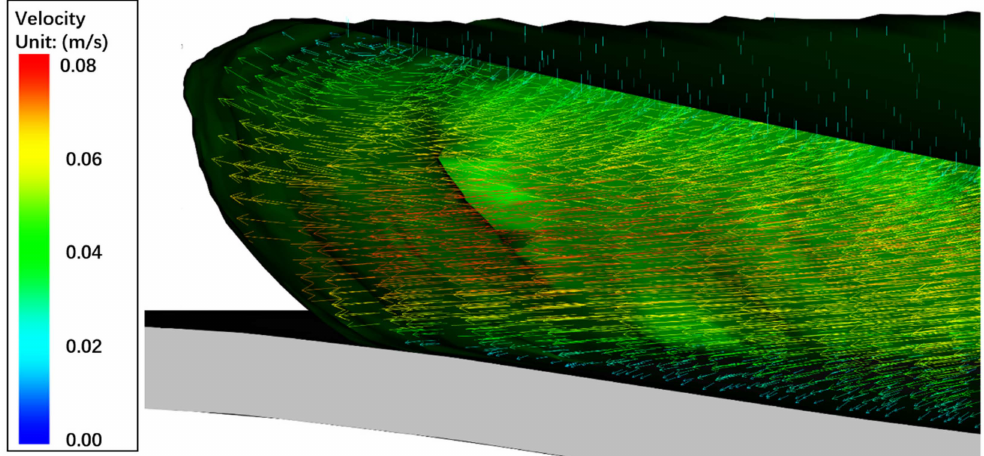
Figure 20. Velocity field of the compression flow